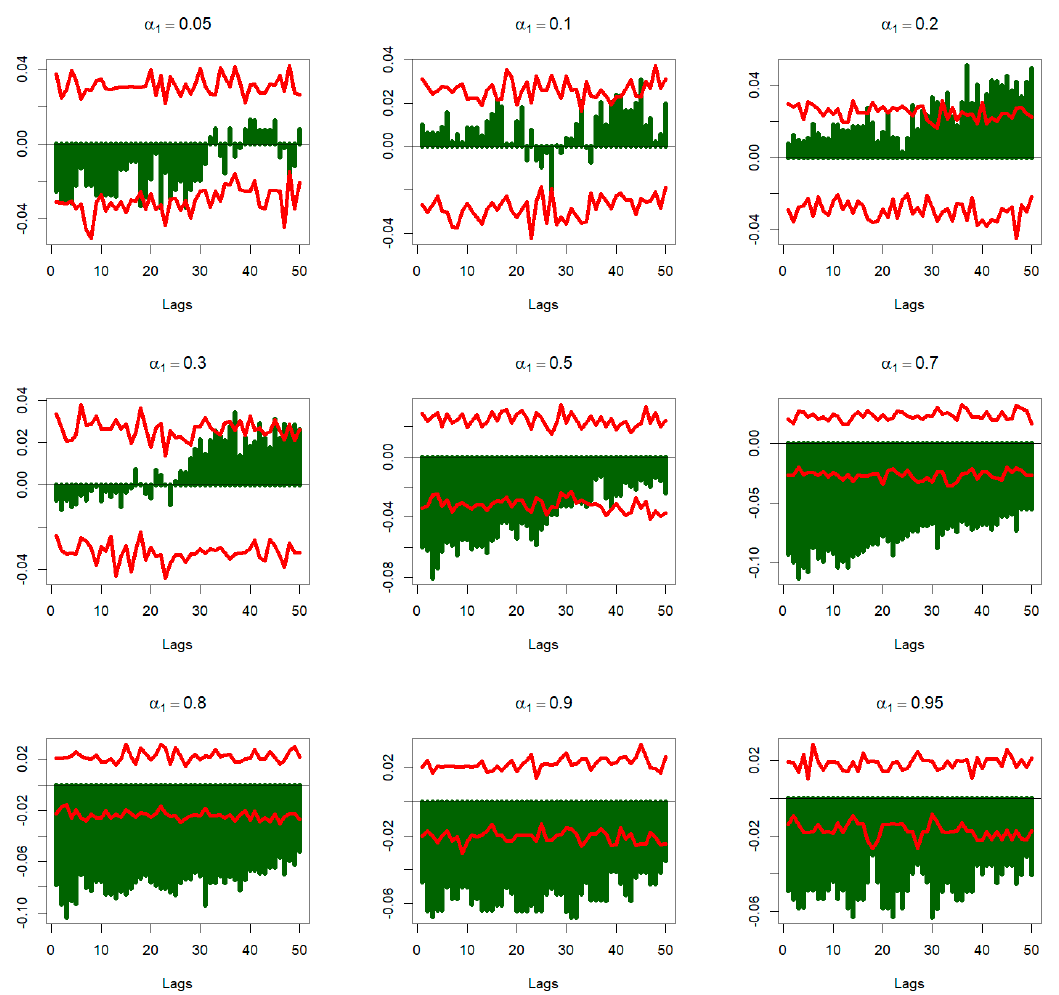
Figure 3. Sample cross-quantilograms for the high levels of TVRAs, i.e., for α 2 = 0.9. Note: This figure depicts the sample cross-quantilograms ( ˆ q a ( k )) to detect directional predictability from time-varying risk aversion measure (TVRA) to realized correlation jumps ( RCJ t ) , by estimating the lead-lag correlations contemporarily at di ff erent lags and quantiles. As for RCJ t , six quantiles are considered, in which ∈ { 0.05,0.10,0.20,0.30,0.40,0.5,0.60,0.70,0.80,0.9,0.95 } As for TVRA, three quantiles are considered, in which α 2 ∈ { 0.9 } corresponding to periods in which the TVRA is in its high levels. Bar graphs depict the ˆ q a ( k ) , while the red lines depict the 95% bootstrap confidence intervals for 1000 bootstrap iterations. For positive (negative) values of the ˆ q a ( k ) , a bar above (below) the red line leads to a rejection of the null hypothesis H 0 : ˆ q a ( k ) = 0 at a 5% significance level.